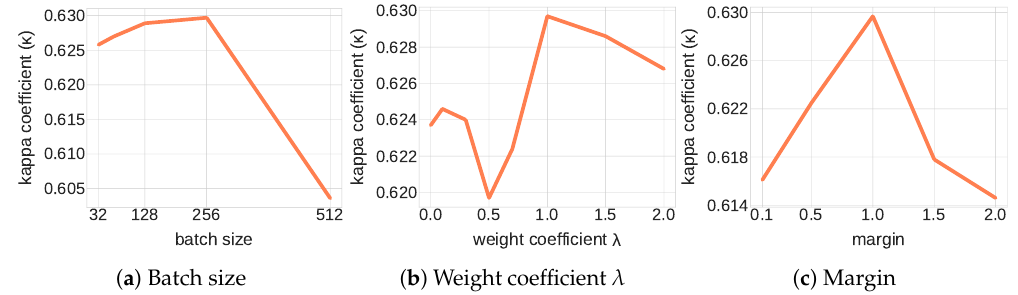
Figure 6. Effect on performance of various hyper-parameters of the proposed approach. ( a ) Batch size effect on performance of TripletLSTM-1. ( b ) Weight coefficient λ effect on performance of TripletLSTM-1. ( c ) Margin effect on performance of